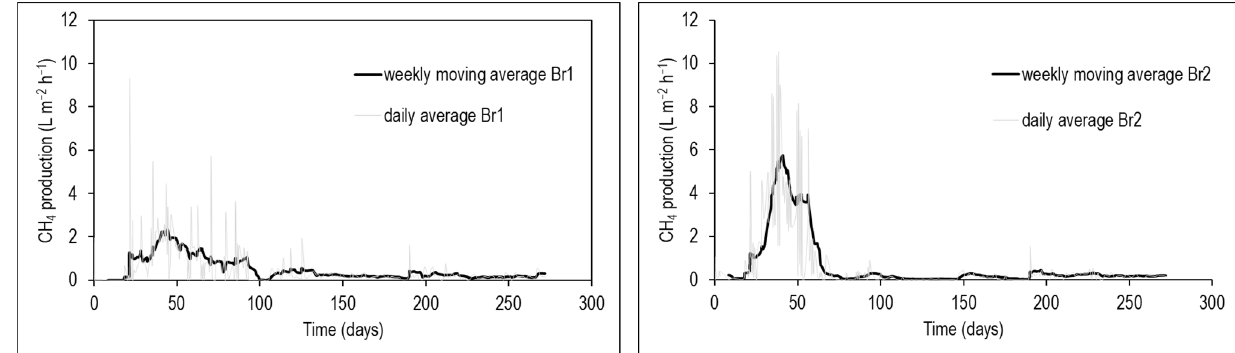
Figure 5. Methane production rate in bioreactors.